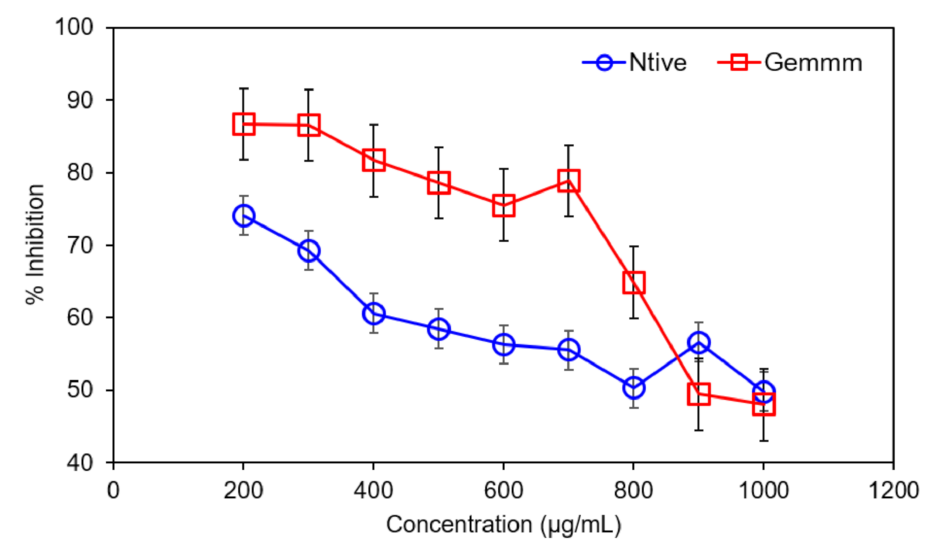
Figure 5. DPPH radical scavenging activity of Native and gemm extracts of H. griffithi